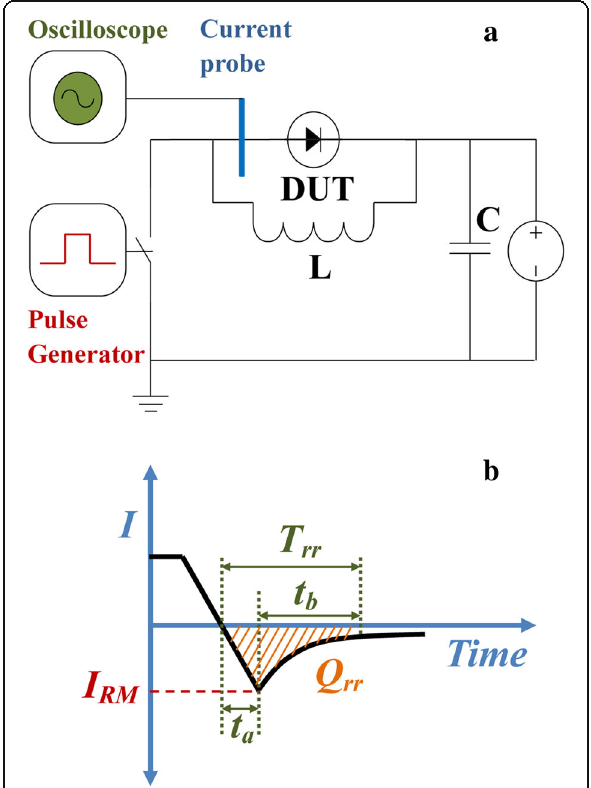
Fig. 3 a The test circuit used to measure the reverse recovery characteristics of vertical SBDs. b Schematic waveform of reverse recovery characteristics of vertical